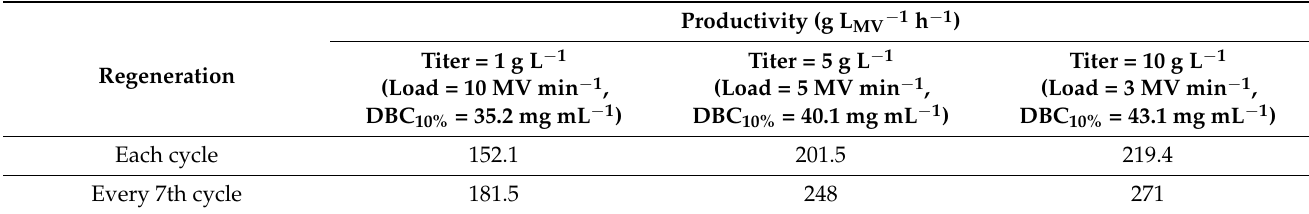
Table 7. Highest productivity to be achieved in dependency of titer, flow rate during load, DBC 10% and CIP